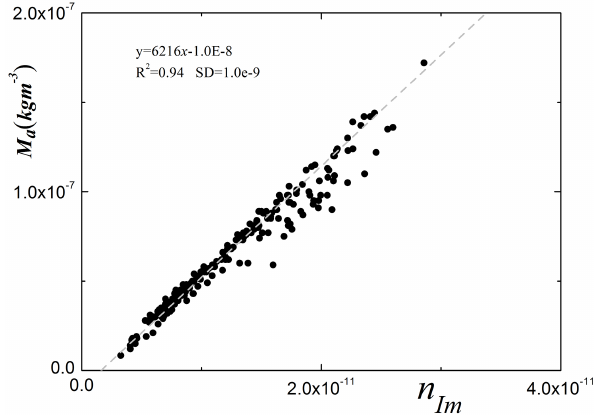
Figure 5. Temporal variations in the real part of the AERISP (a) , and imaginary part of the AERISP (b) observed during 20–29 De- cember 2014.